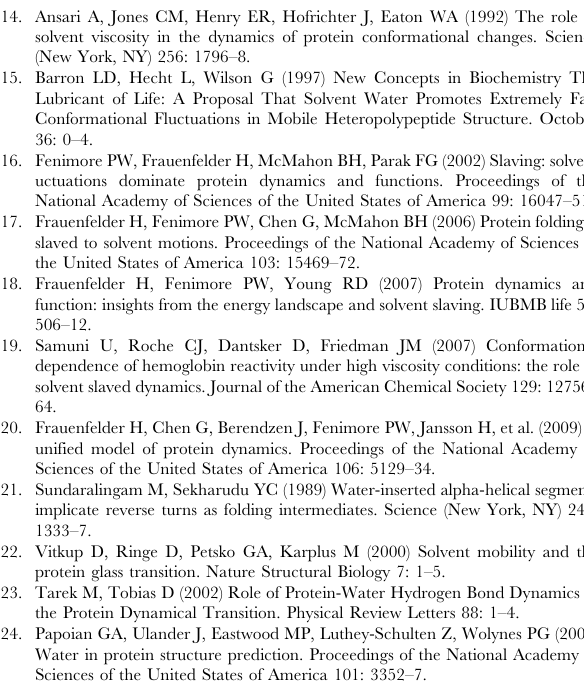
Figure S2 Average Pearson correlation coefficient r between E p and E p { w calculated with various n (see Eq. 3) as a function of time scale for barstar.